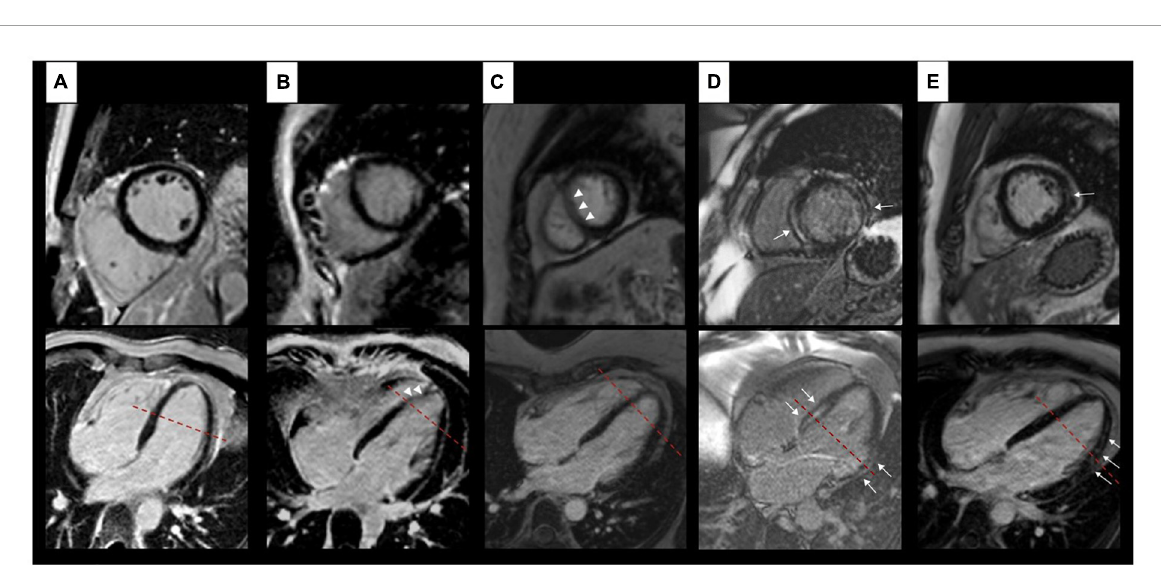
FIGURE2 Findings on LGE images. Artefact-free images of a healthy control (A) . Columns (B,C) show examples of artefacts in patients with LBBB each resulting in an amorphous signal increase within the myocardium (white arrow heads) without a correlate in an intersecting plane. Examples of true LGE (white arrows) in patients with LBBB are shown in columns (D,E) . Here, both planes show an intramyocardial (septum) and subendocardial (free wall) signal increase (D) respectively a typical subepicardial signal increase (E) . The red dashed lines depict the respective intersection of both planes